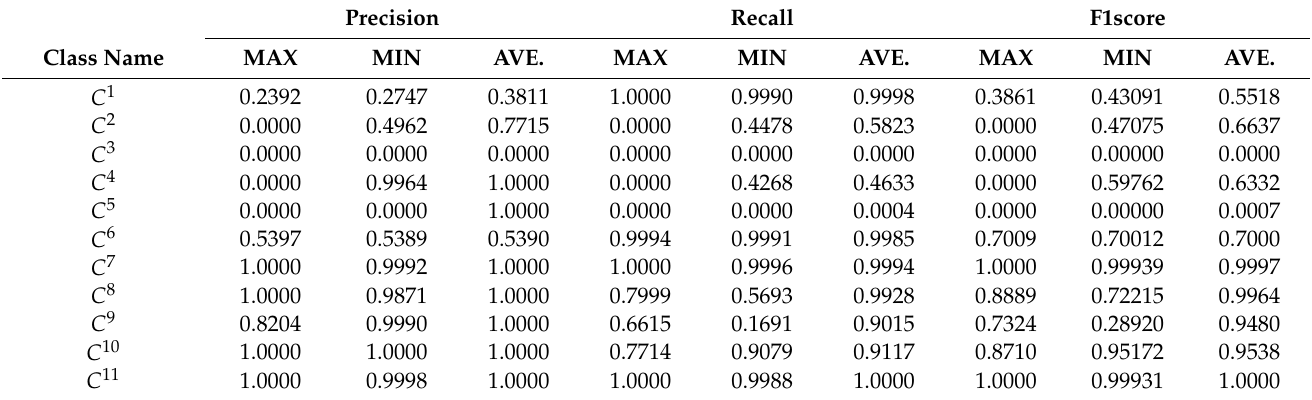
Table 13. Performance analysis for N-BaIoT with LR and MI feature selection on the test dataset. Precision